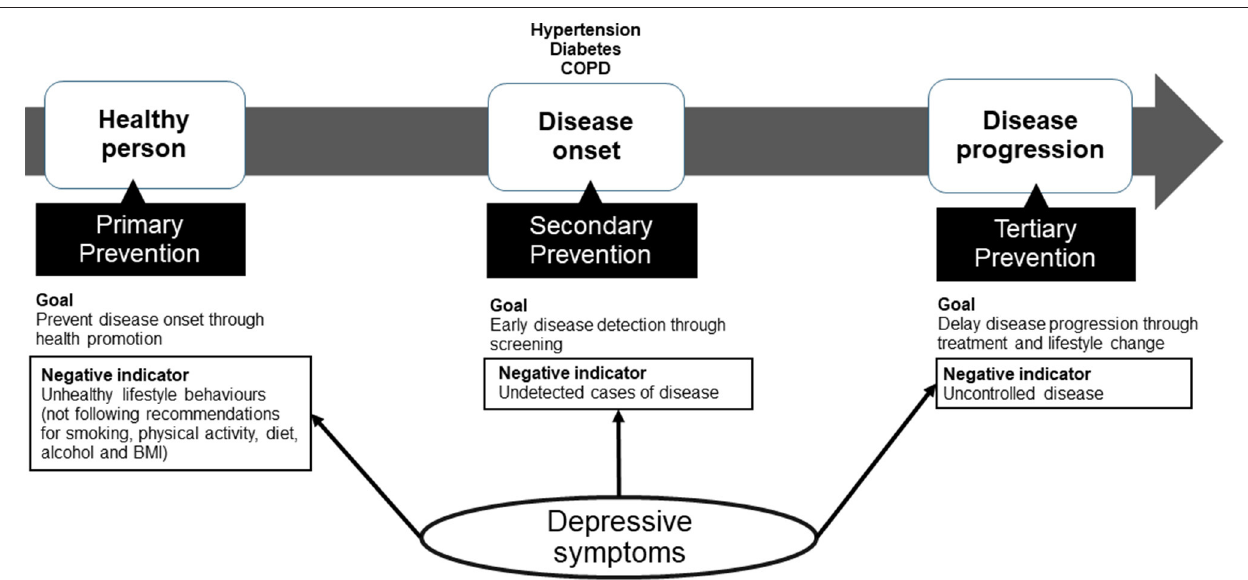
FIGURE 1 | Conceptual framework. Primary care participants exist on a disease continuum, from a healthy person to disease onset, to disease progression. Primary healthcare aims to prevent people from moving forward along the continuum. Primary, secondary and tertiary prevention strategies target people at different stages of the disease continuum. To evaluate gaps in primary, secondary and tertiary prevention in Kosovo’s PHC system, our study assesses negative indicators of each stage of prevention. Specifically, it describes the prevalence of lifestyle risk factors (targets if primary prevention), as well as undetected hypertension, diabetes and chronic obstructive pulmonary disease (COPD) (targets of secondary prevention) and uncontrolled hypertension, diabetes and COPD (targets of tertiary prevention) among Kosovo PHC users. It further assesses the association between depressive symptoms and these indicators to evaluate whether depressive symptoms act as a barrier to disease